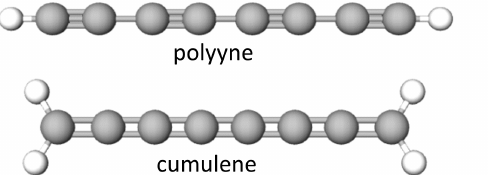
Figure 1. A picture reporting the two allotropic forms of sp-hybridized carbon wires for n = 8: the more stable polyynes with alternated triple and single bonds between carbon atoms (–C ≡ C–) n and cumulenes with extended carbon double bonds along the chain (=C=C=) n